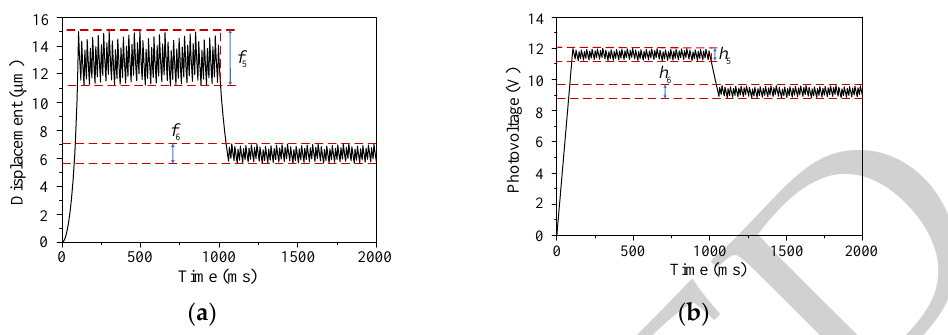
Figure 9. The closed-loop control simulation curve of photovoltaic-electrostatic hybrid actuator il-